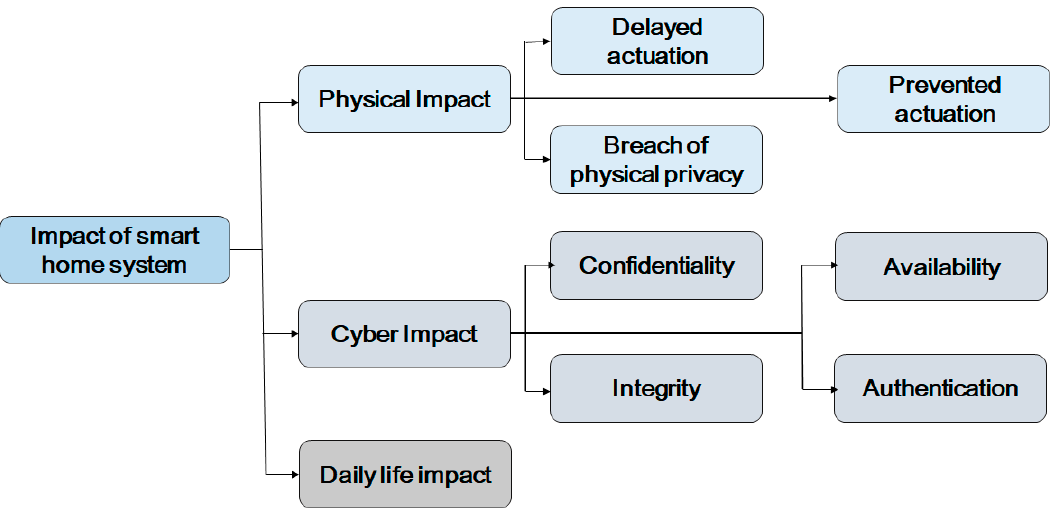
Figure 5. Impact of the smart home system.